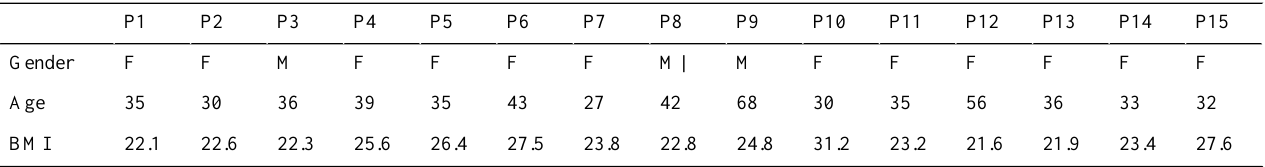
Table 1. Participant demographics and BMI.